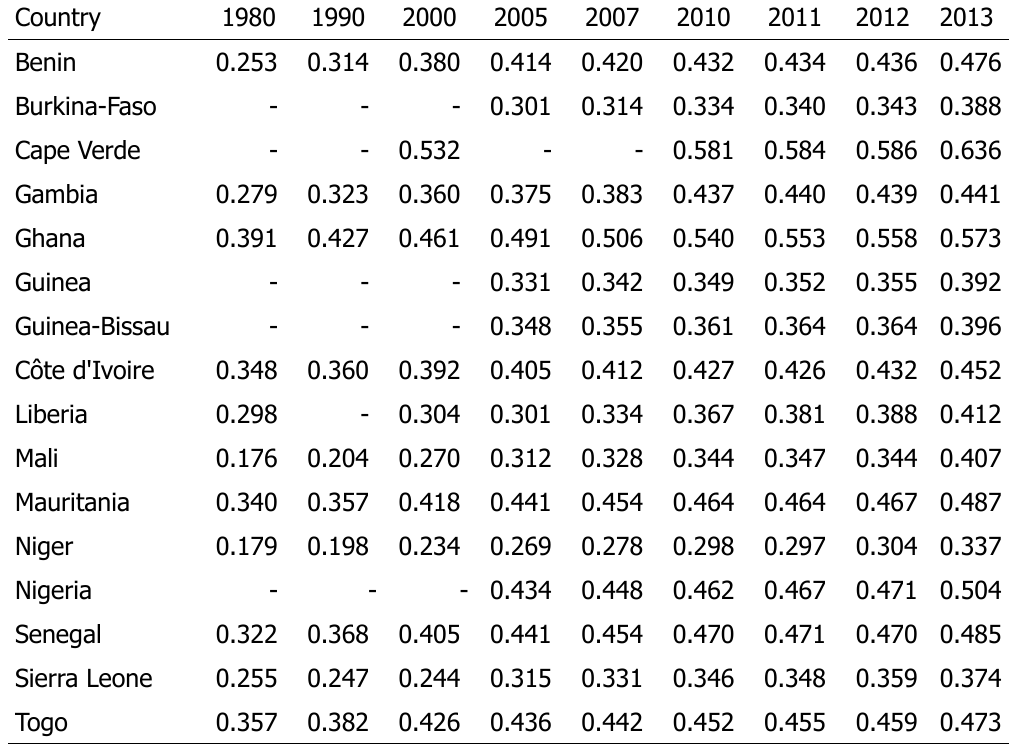
Table 1. Human development index (HDI) trends for countries in West Africa, 1980‒2013.